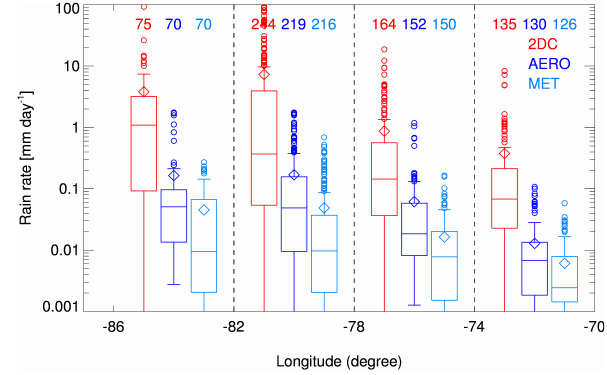
Fig. 12. Box and whisker plots of longitude-binned rain rates from in-cloud measurements (red) by a 2D-C probe onboard the C-130 aircraft and from corresponding in-cloud values in the AERO (blue) and MET (light blue) simulations. The bottom and top of the box are 25th and 75th percentiles. The median is shown inside the box. The 10th and 90th percentiles are shown by the dash outside the box. The open circles indicate outliers (lower than 10th or higher than 90th percentiles). The diamonds show the mean over all legs in each longitude bin. The numbers on the top indicate the number of data points used to produce the box and whisker